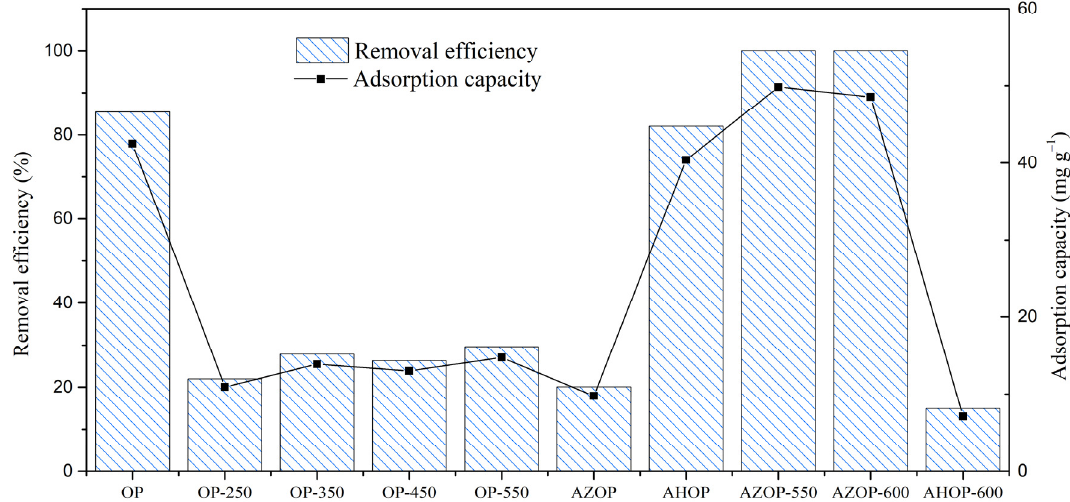
Figure 2. Comparison of MB removal efficiency and adsorption capacity for the different adsorbent materials.